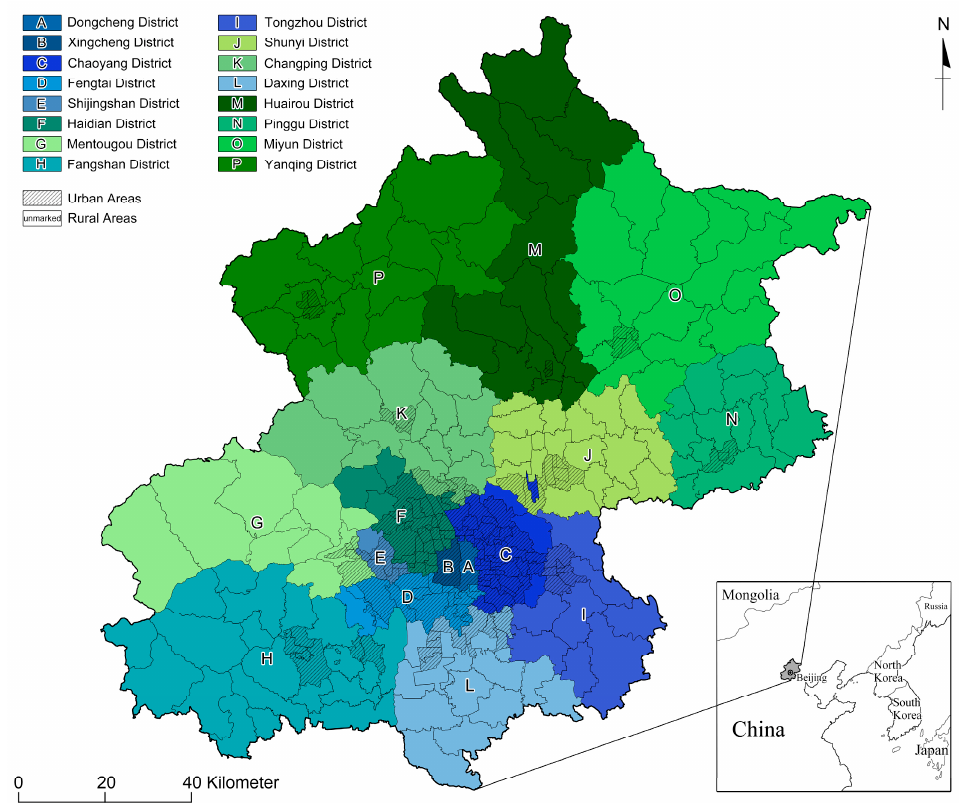
Figure 1. A map showing the 16 stratified districts in Beijing where this study took place.